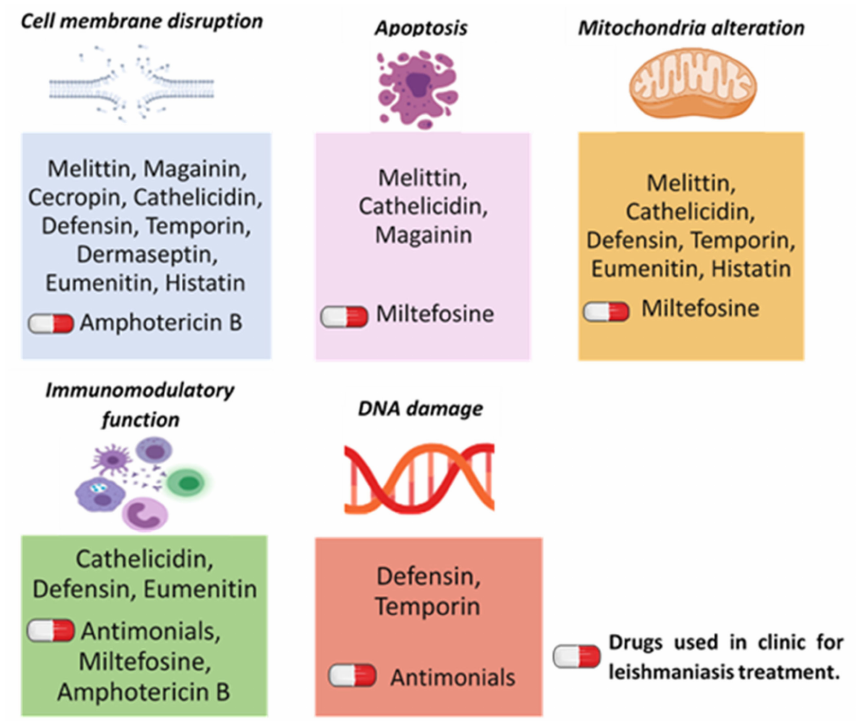
Figure 1. General mechanisms of action of the different families of AMPs with anti-leishmanial activity. Cell membrane disruption is the main mechanism of action adopted by all the described AMPs [50–59] While some of them present additional mechanisms of action (apoptosis,